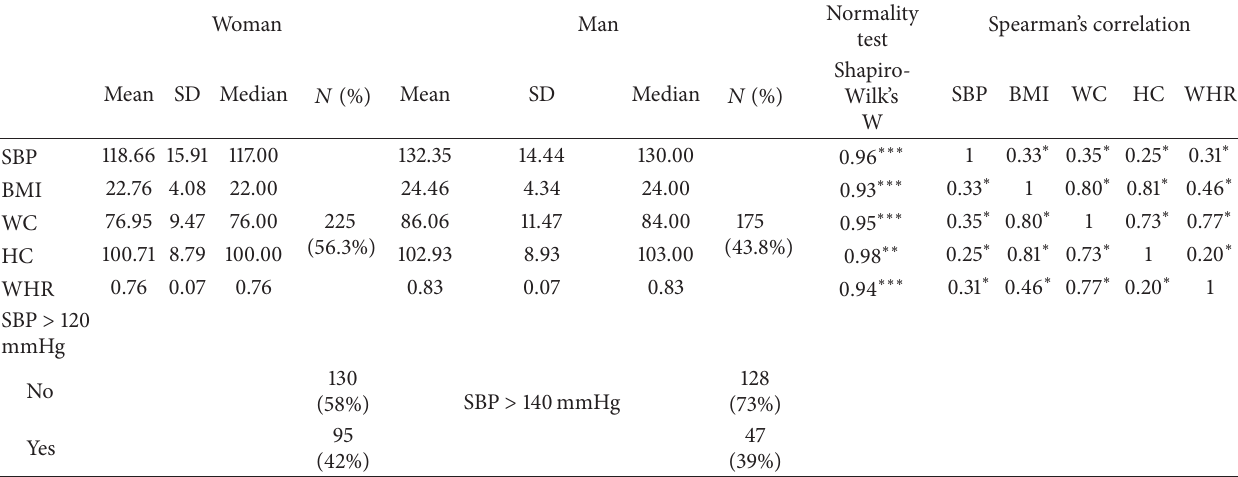
Table 1: Descriptive statistics for SBP, BMI, WC, HC, and WHR; prevalence of obesity for woman and man; test of normality and correlations.